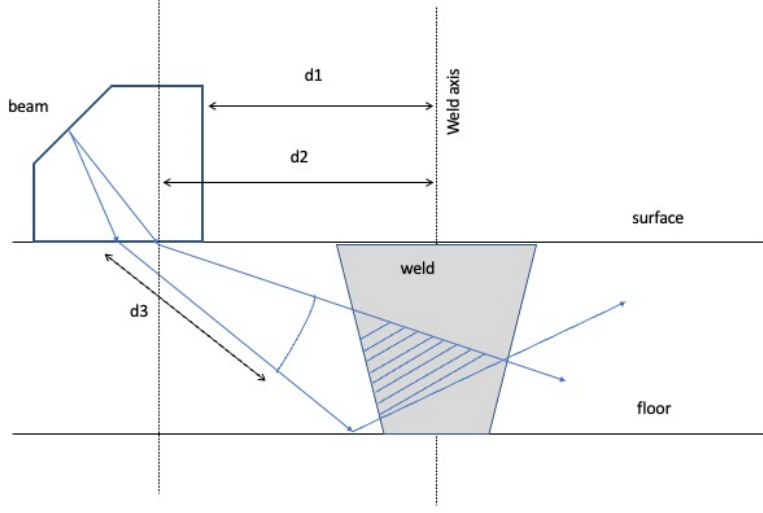
Figure 2. Geometry of the PA inspection.